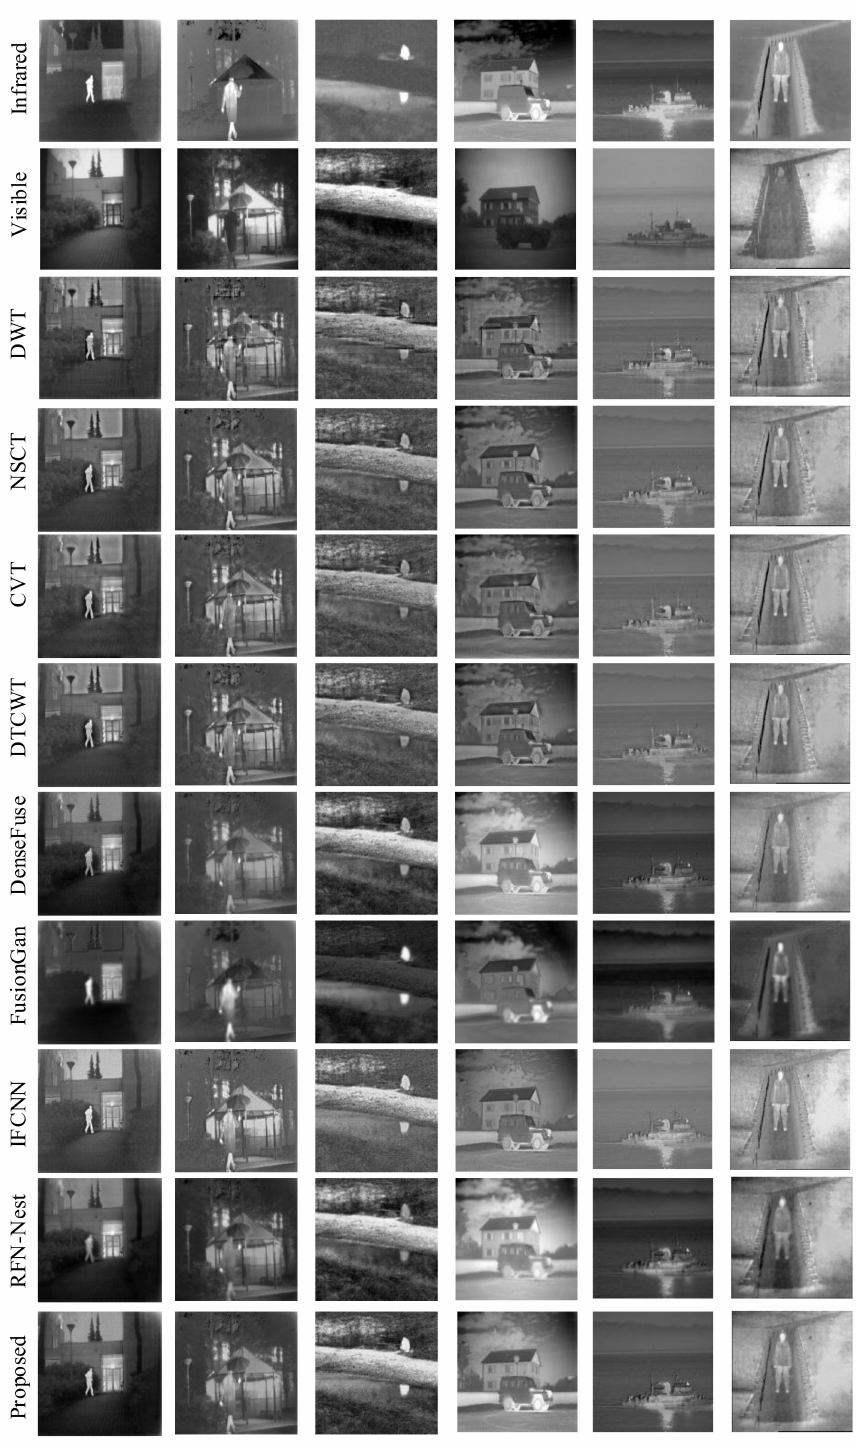
Figure 6. Subjective comparison between the proposed method and other state-of-art methods on 6 pairs of images from TNO